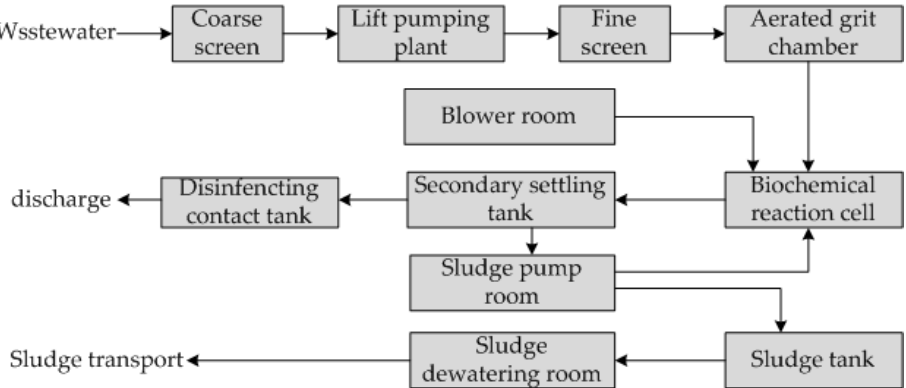
Figure 1. Process flowchart of a sewage treatment plant in Northeast China.